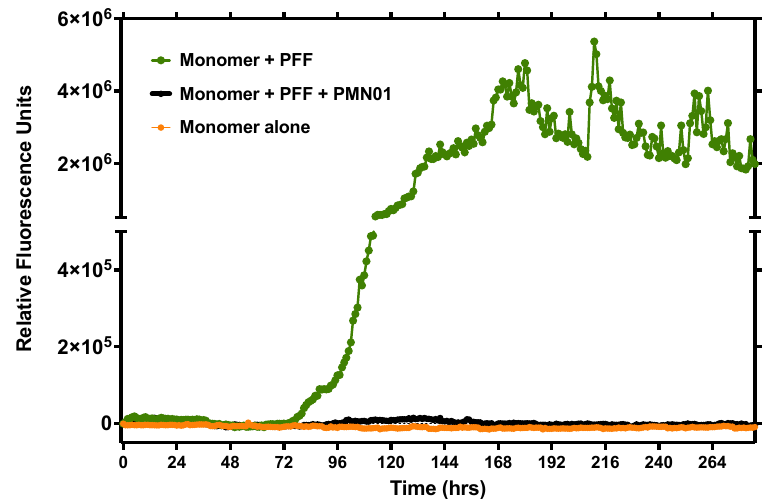
Figure 8. mAb inhibition of PFF seeding activity. Aggregation was tracked hourly with a ThT fluorescent assay (shaking for 30 sec prior to each reading) after the addition of α -syn monomers alone (100 mM) or in the presence of sonicated human PFF (10 nM) as a seeding agent, without or with mAb (0.1 nM). Data are representative of 2 independent experiments.